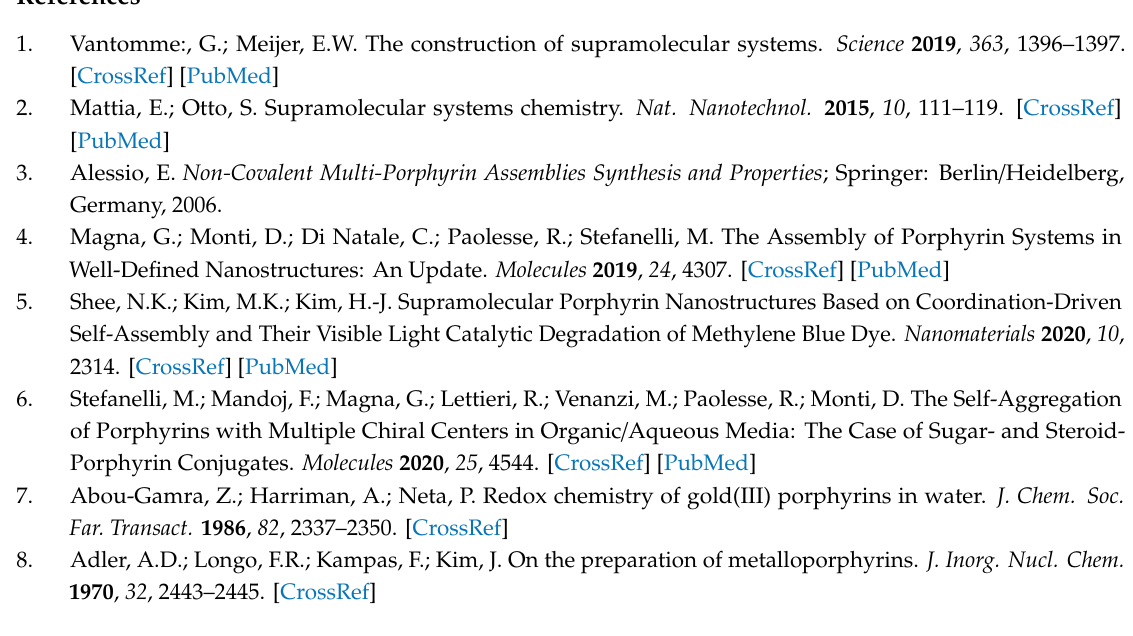
Figure S4: RLS intensity and extinction vs. [MnT 4 ], Figure S5: Autocatalytic rate constants k c and the values of m and n for the aggregation of TPPS 4 as function of [ZnT 4 ], Figure S6: RLS intensity and extinction vs. [ZnT 4 ], Figure S7: UV / Vis extinction spectra of TPPS 4 J-aggregates in the presence of AuT 4 , CoT 4 , ZnT 4 and MnT 4 , Table S1: Kinetic parameters for TPPS 4 aggregation vs. [MT 4